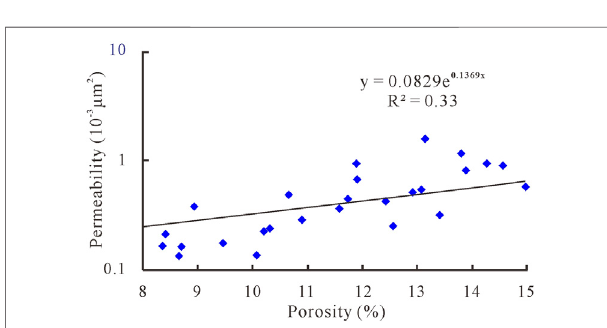
FIGURE 6 | Relationship between porosity and permeability of the tight sandstone samples in the Chang 3 Member.